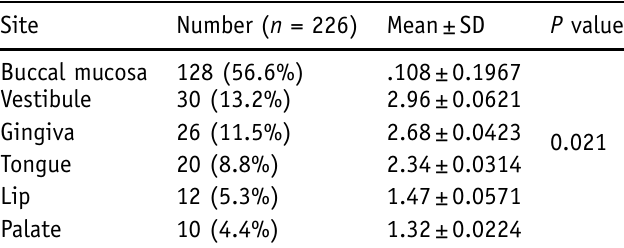
Table II. Distribution of lesions based on site.